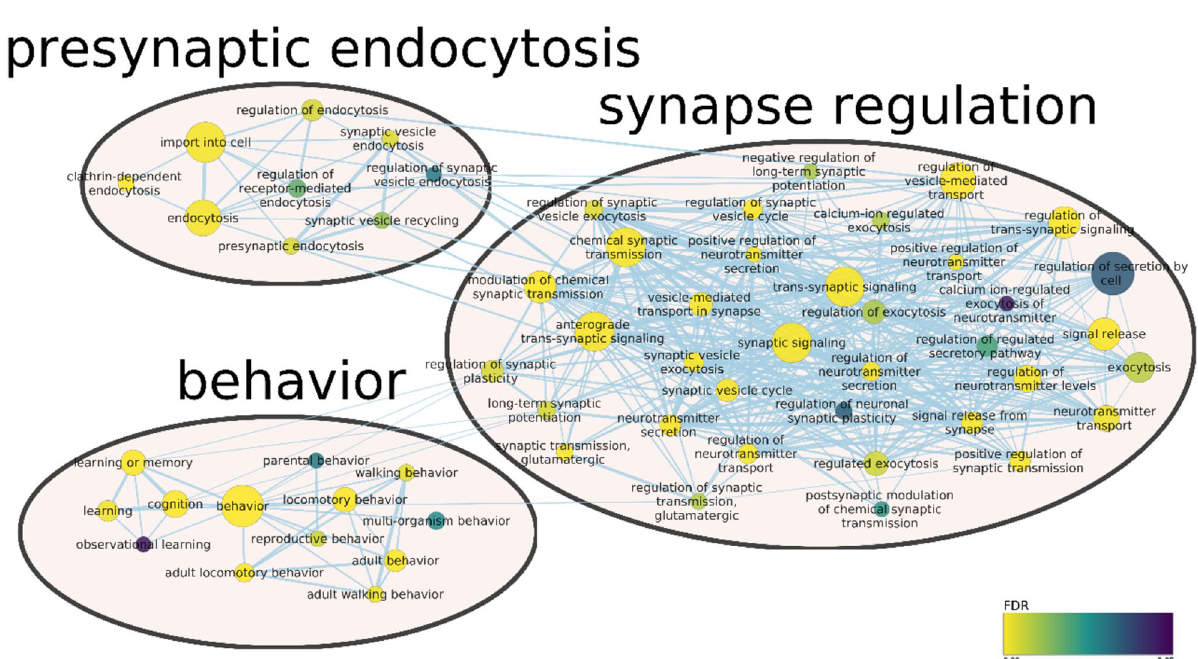
Figure 4. Sub-network from enriched GO terms by g:Profiler in encephalon and visualized in Cytoscape after clustering with Autoannotate. Node size correspond to number of genes expressed from the term; edge size represents the number of genes that overlap between different terms; node colour represents the significance level